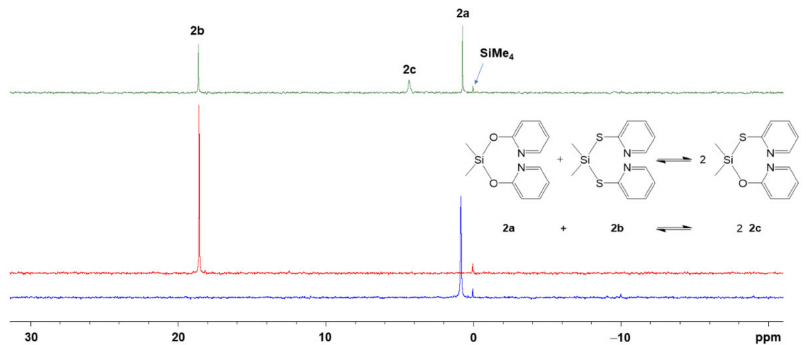
Figure 7. Stack plot of 29 Si{ 1 H} NMR spectra of (from bottom to top) a 0.88 M solution of 2a in CDCl 3 (blue trace), a 0.88 M solution of 2b in CDCl 3 (red trace) and of an equimolar mixture of these stock solutions (green trace) as well as a reaction scheme and signal assignment. We attribute the signal broadening for 2c to dynamic effects in the Si coordination sphere (cf. Section 3.2.3, computational analyses of conformers and isomers of compound 2c ).